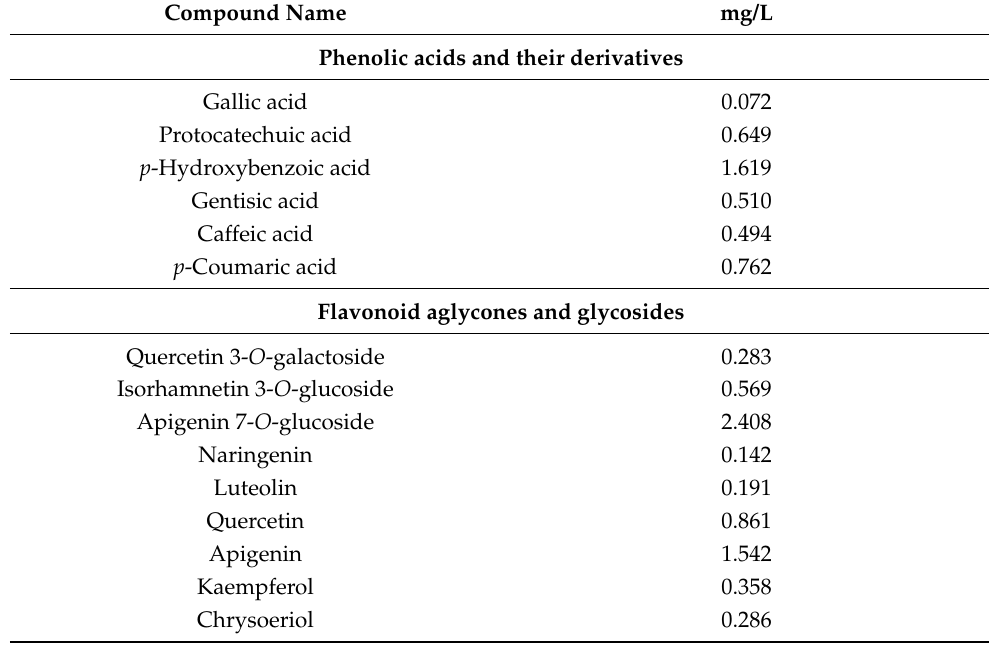
Table 2. Concentration (mg/L) of individual phenolics found in optimal chamomile